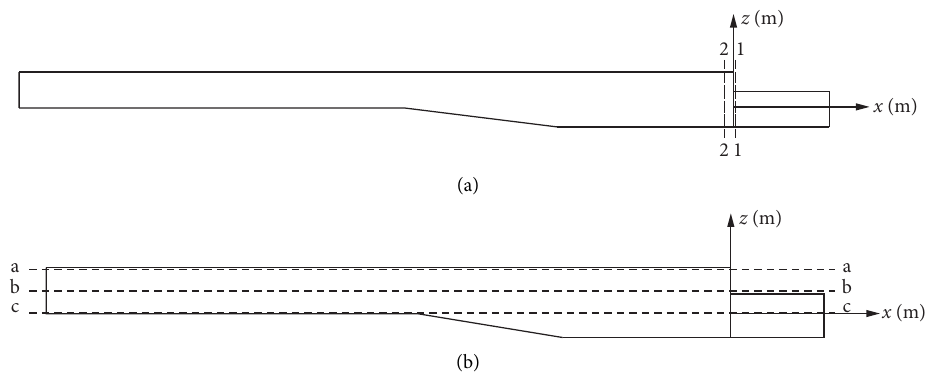
Figure 4: Schematic diagram of the position of each section. (a) Schematic diagram of vertical profile position. (b) Horizontal section position diagram.